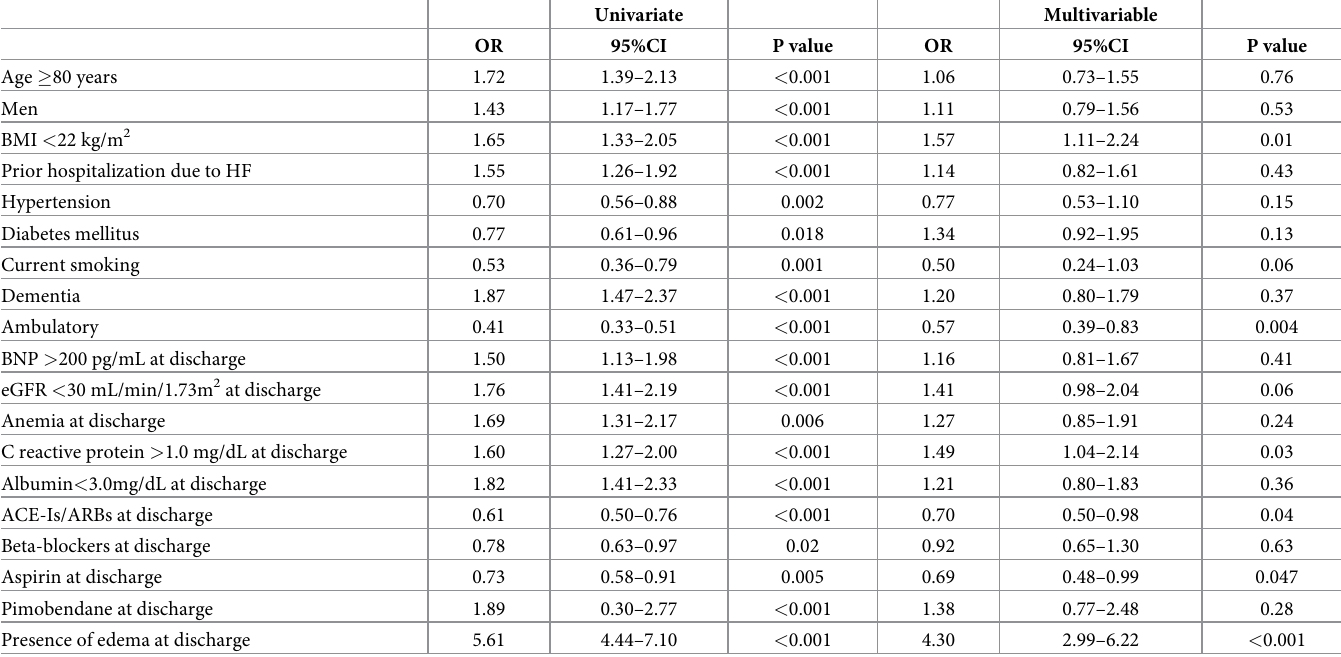
Table 2. Factors associated with appetite loss at